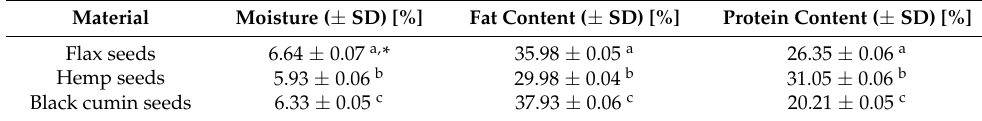
Table 1. Basic chemical composition of seeds. Material Moisture ( ± SD) [%] Fat Content ( ± SD) [%] Protein Content ( ± SD) [%] Flax